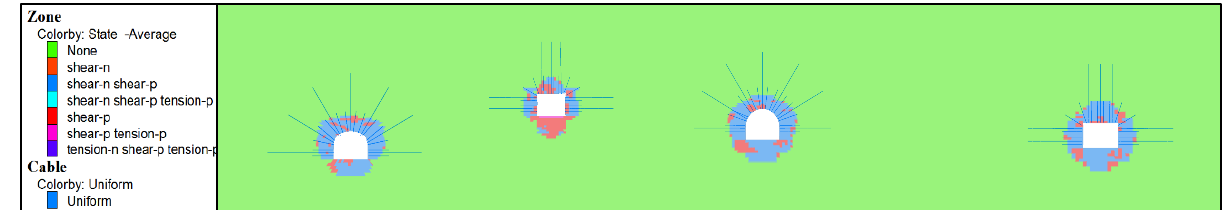
Figure 10. Displacement of surrounding rock behind the excavation roadway group.